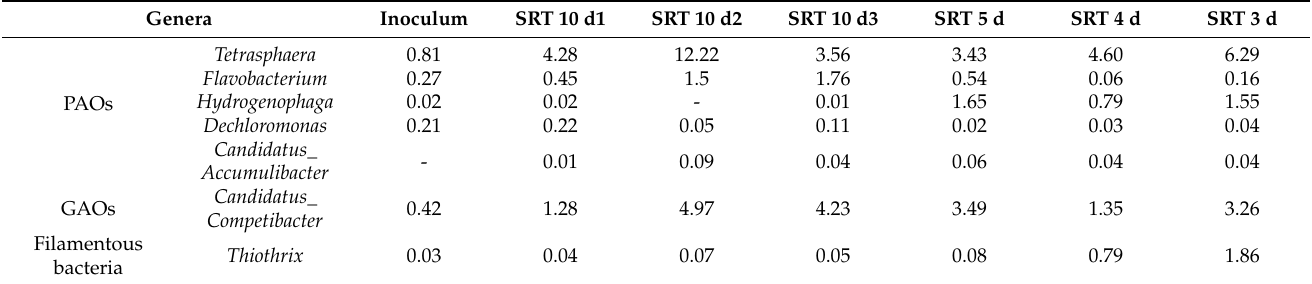
Table 3. Functional genera related to phosphorus removal and system